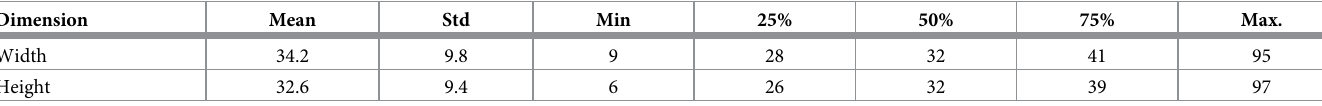
Table 12. Descriptive summary (mean, range and percentiles) of the cells’ dimensions in the scaled images. Dimension Mean Std Max. Height Descriptive summary (mean; standard deviation; minimum; first, second, and third quartiles; and maximum) related to the width and height of the cells present in